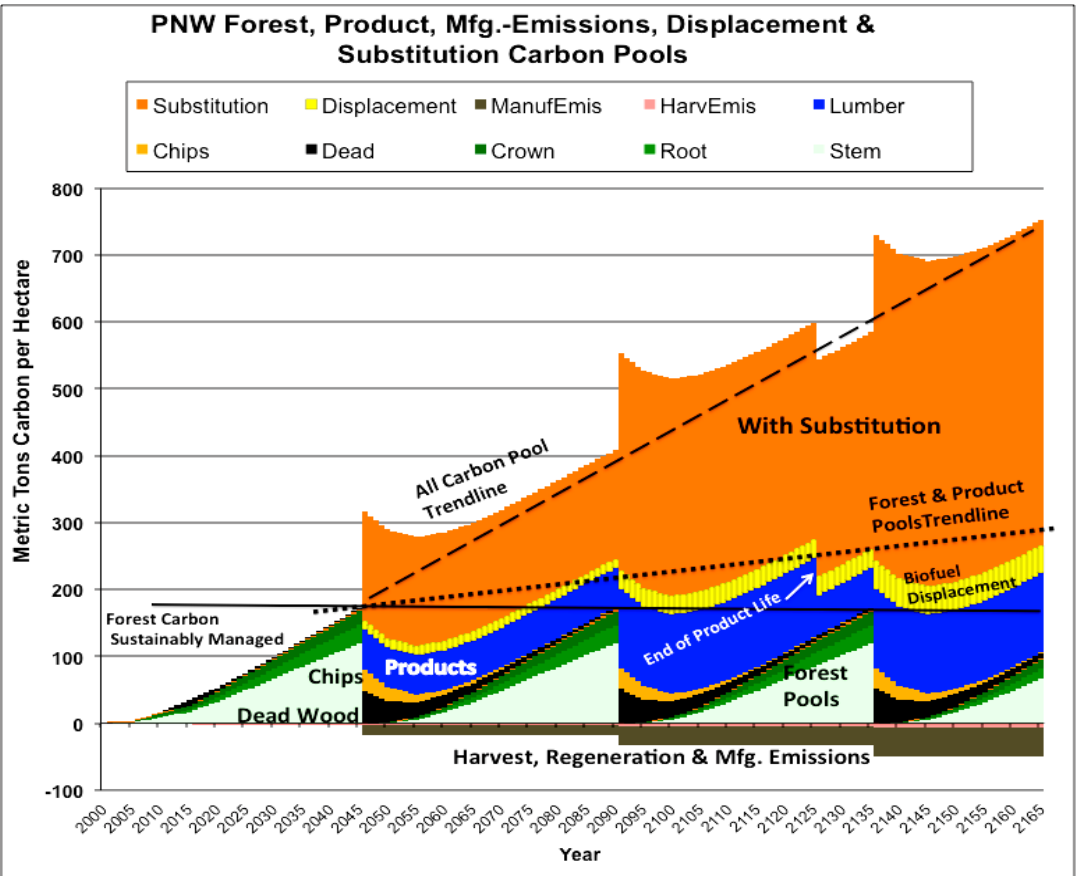
Figure 1. Carbon pools from a sustainably managed forest stand and its wood products, including biofuel displacement from mill residuals and product substitution.